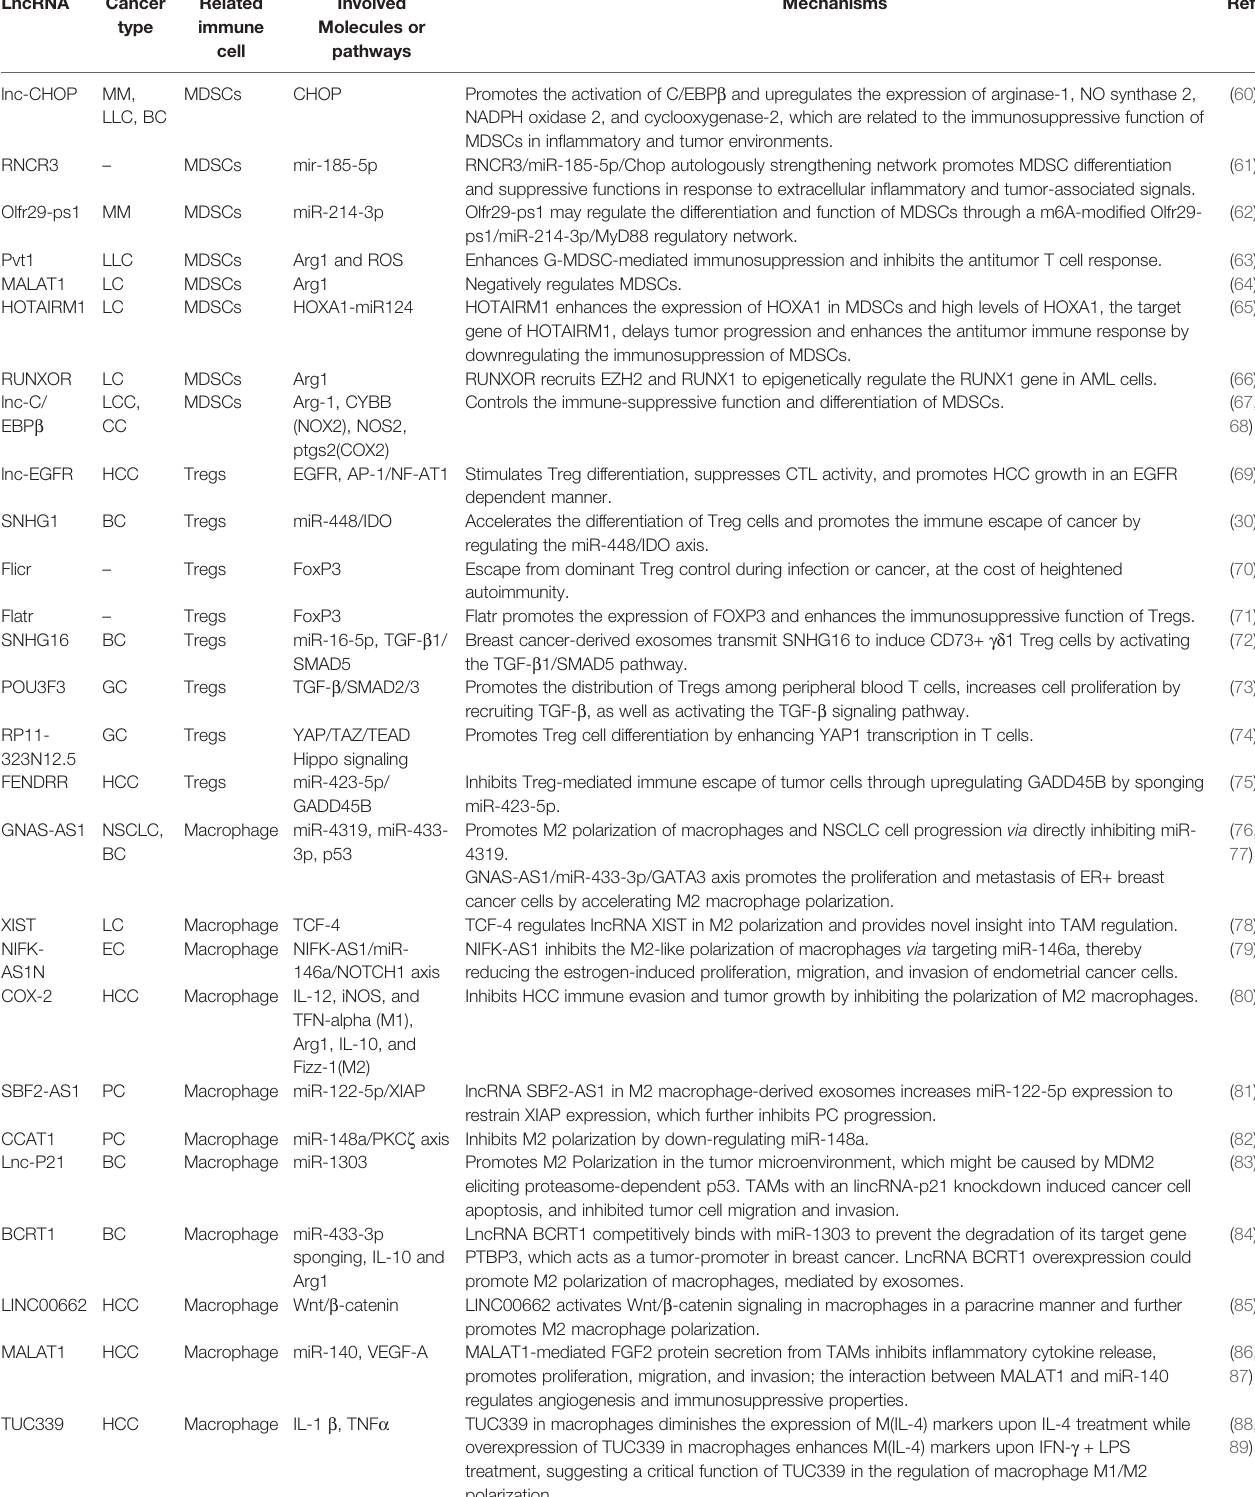
TABLE 1 | Summary of evidence for the role of lncRNA in the tumor immune microenvironment.